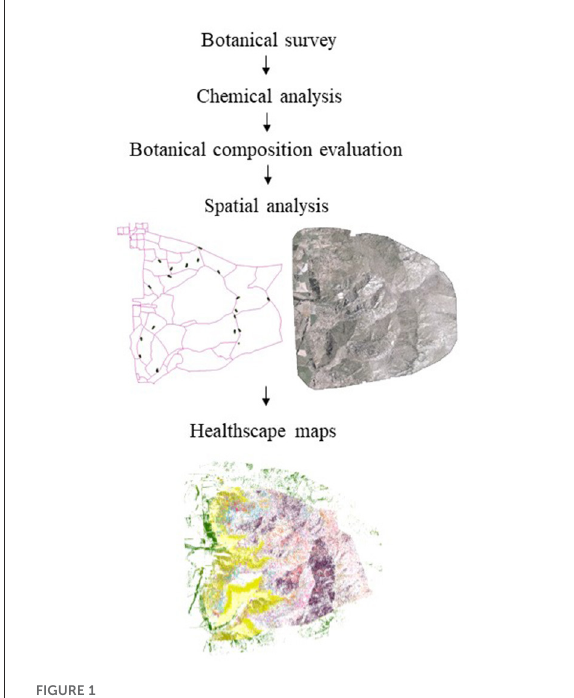
FIGURE1 Spatio-chemical analysis methodology chart to